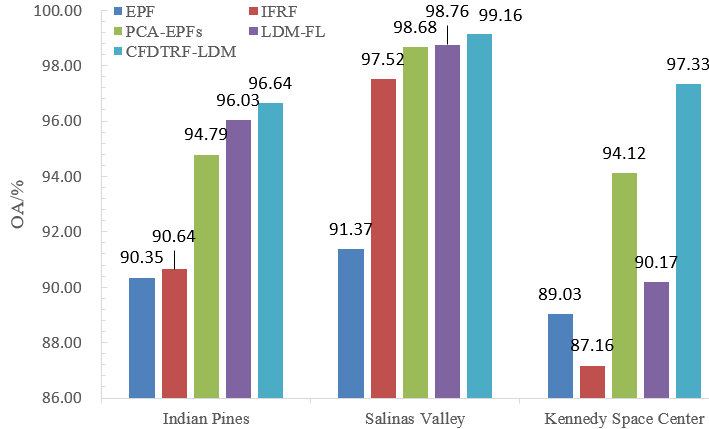
Figure 14. Comparison of EPF, PCA-EPFs, IFRF, LDM-FL and CFDTRF-LDM on three datasets.